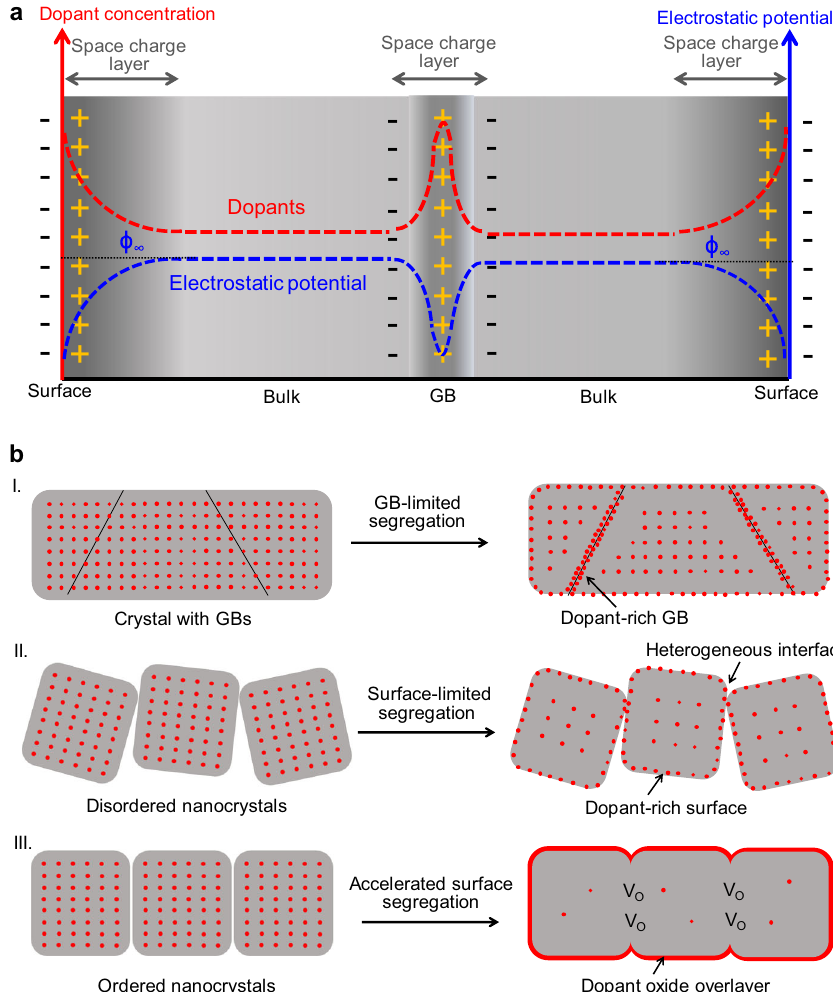
Fig. 1 Space charge-induced dopant segregation. a Distribution of dopants and electrostatic potential (donor-doping case) in ionic oxides based on the space charge theory (Supplementary Fig. 1 for acceptor-doping case). Strong segregation of dopants in the space charge layers is induced to compensate the excess charges on the crystal surfaces and bulk GBs (Supplementary Fig. 2). See Supplementary Note 1 for more details on the space charge theory. b Schematic illustration of the dopant segregation in different types of ionic oxide crystals: (I) Crystal with numerous GBs: dopants tend to segregate at the surface and GBs. (II) Disordered nanocrystals: a small number of dopants tend to segregate on the surface due to the lack of driving force even at high temperatures. (III) Ordered nanocrystals with highly aligned interfaces: a large number of dopants segregate on the outer surface because of interface sintering (GB elimination), creating numerous interfacial V O and narrowing the space charge layer to drive the charge